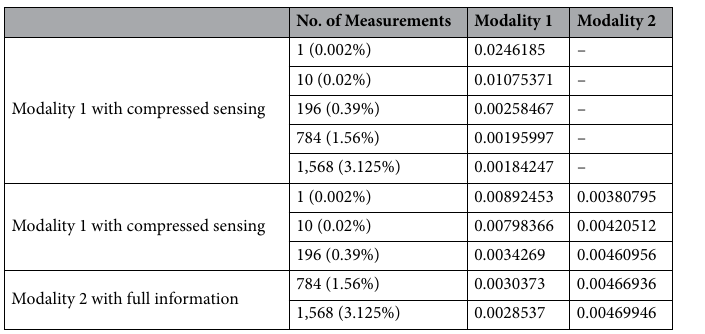
Table 3. Asymmetric compressed sensing. Mean reconstruction error over 50 WiFi spectrogram data samples. Noise standard deviation: